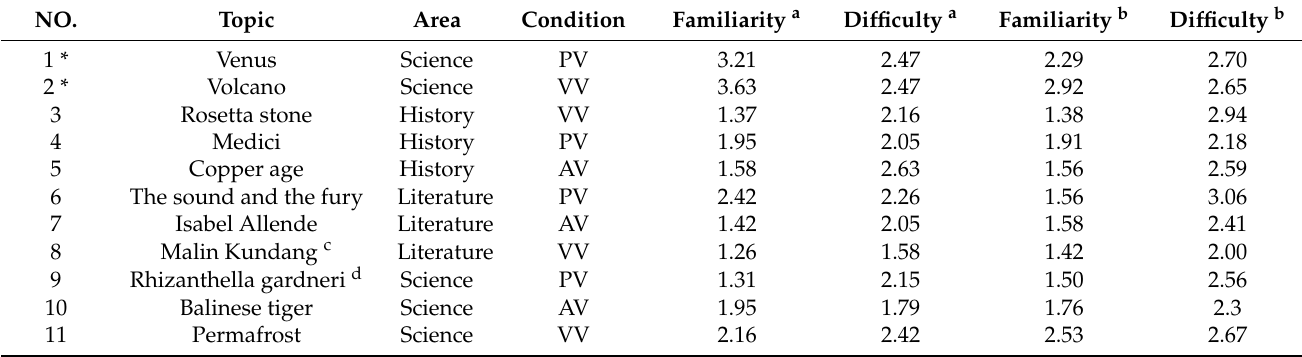
Table 1. Descriptives of 11 lecture videos.